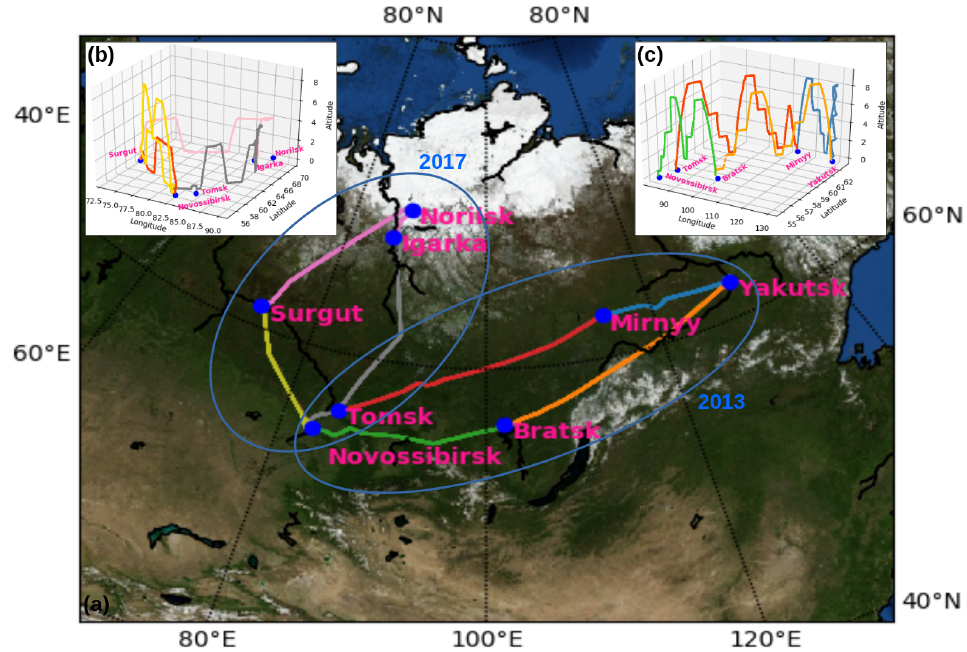
Figure 1. ( a ) Map of the 8 aircraft flight tracks carried out in 2013 (eastern loop) and in 2017 (northern loop). The aircraft altitude ranges in km ASL are also shown for the 2017 ( b ) and 2013 ( c ) flights. Each color corresponds to a given flight. The red and yellow flights in June 2017 are along the same track. Map background: NASA’s Earth